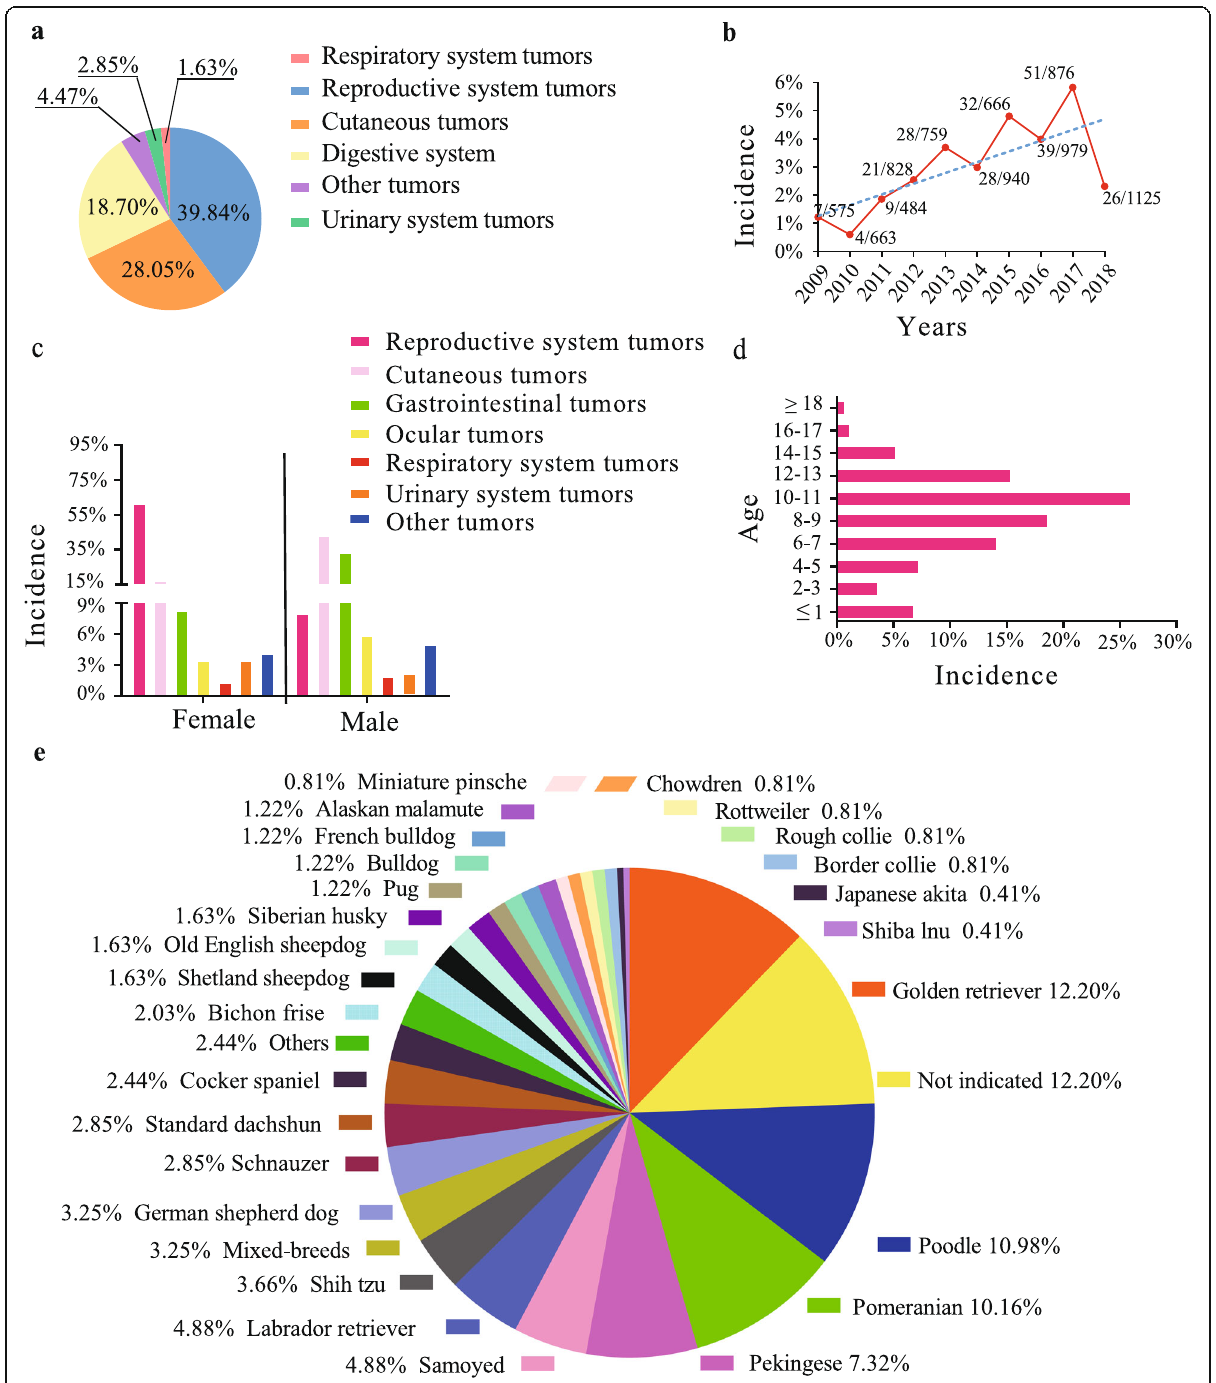
Fig. 1 Correlation of sex, age and breed with overall tumor occurrences in pet dogs. a Proportion of different types of tumors in pet dogs. b Dynamic changes of tumor incidence in pet dogs from 2009 to 2018. The dotted line represents the linear regression. c Incidence of different types of tumors in male and female dogs. d Distribution of tumor incidence in pet dogs at different age groups. e Proportion of different breeds of dog with